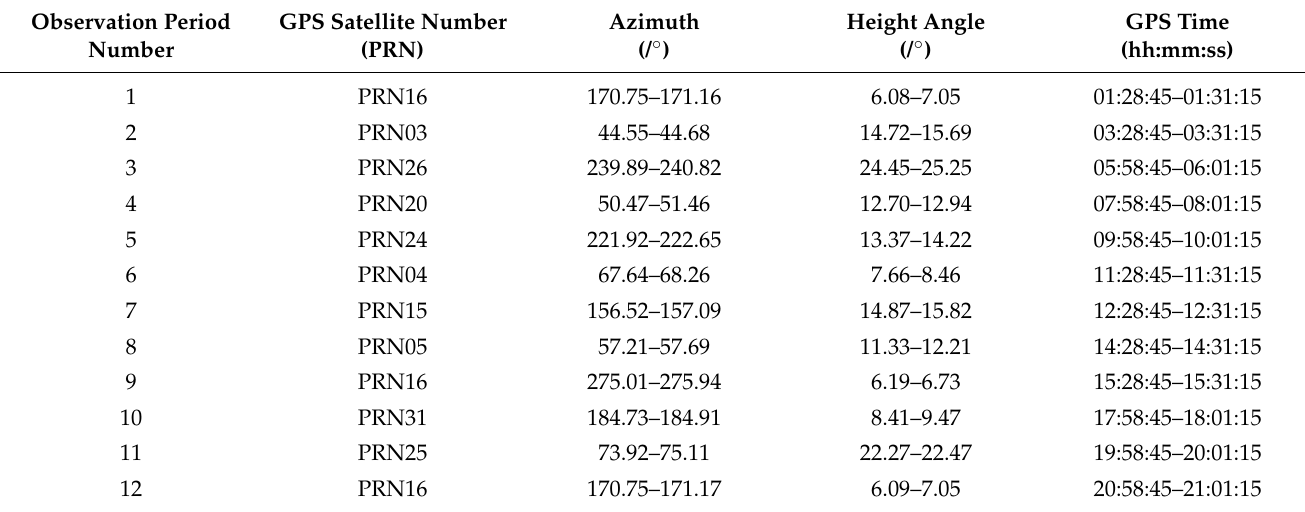
Figure 12. Multisatellite dual-frequency combined multipath error Lomb – Scargle periodogram. Spectrum analysis diagrams of the ( a , c ) dual-frequency carrier phase combined multipath error (L4_IF;) ( b , d ) dual-frequency pseudorange multipath error (MP 2 ). Table 2. Satellite selection results at site P041 on 6 March 2014 (DOY: 2014-065).